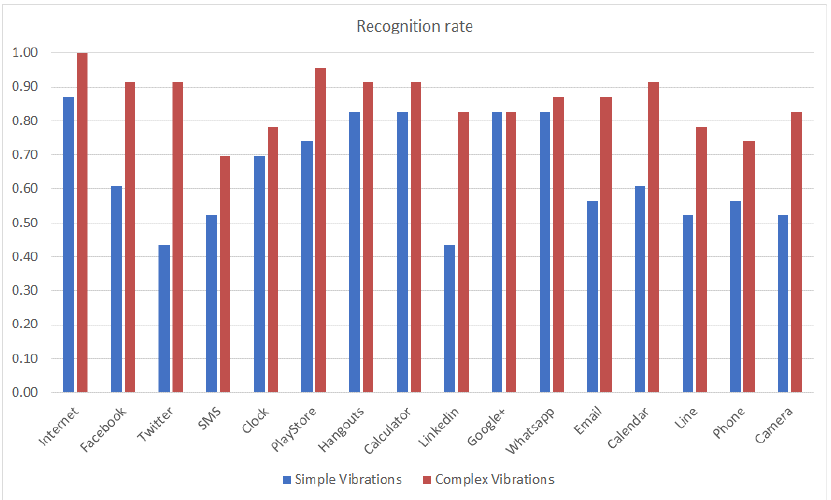
Figure 6. Recognition rate per haptic icon for simple vs. complex vibrations for the whole popula- tion.